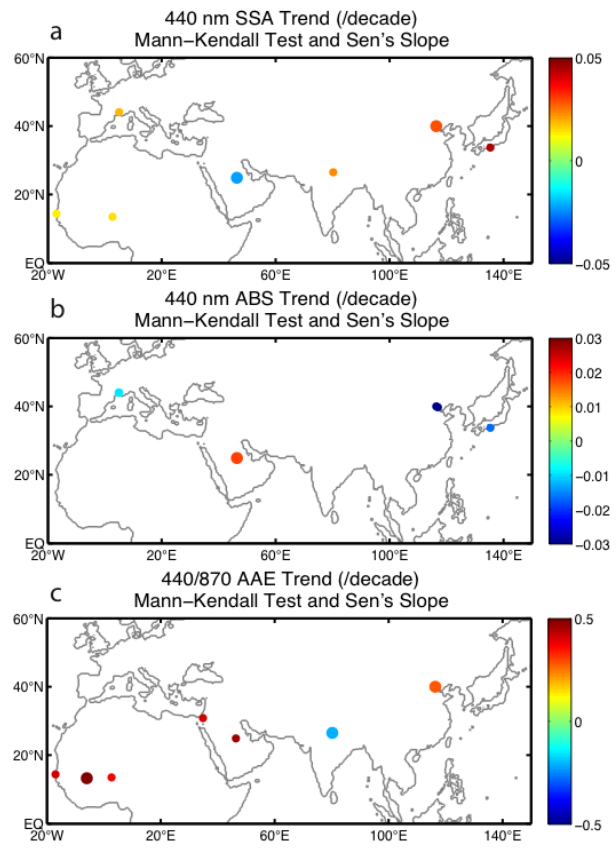
Figure 12. SSA (a) , ABS (b) and AAE (c) trends for the 12 sta- tions selected with AOD > 0.2 threshold. Only statistically signifi- cant ( > 90%) trends are shown. The smaller dots indicate trends at 90% significance, while larger dots indicate trends at 95% signif- icance. The magnitude of the trend (decade − 1 ) is indicated by the color of the dots, following the color scale on the